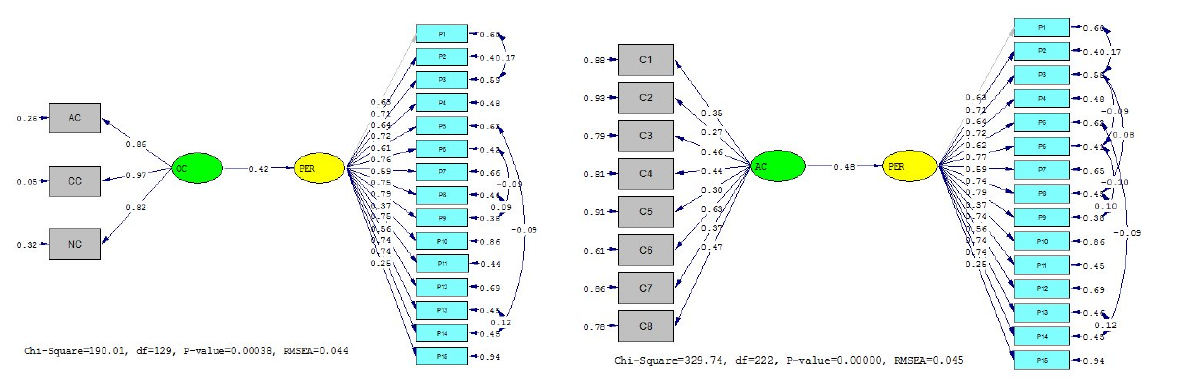
Fig. 2. The model 1 in the standard estimation state Fig. 3. The model 2 in the standard estimation state